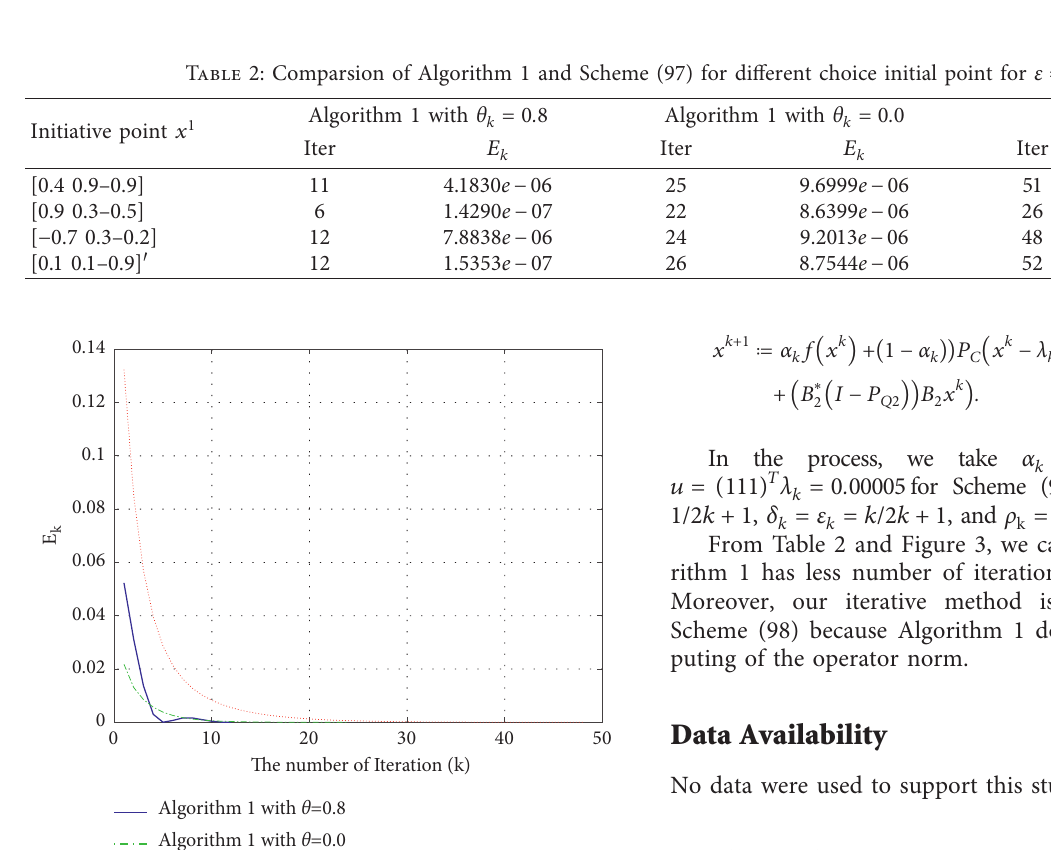
� 0 . 8 and ε � 10 − 5 . k , under θ k